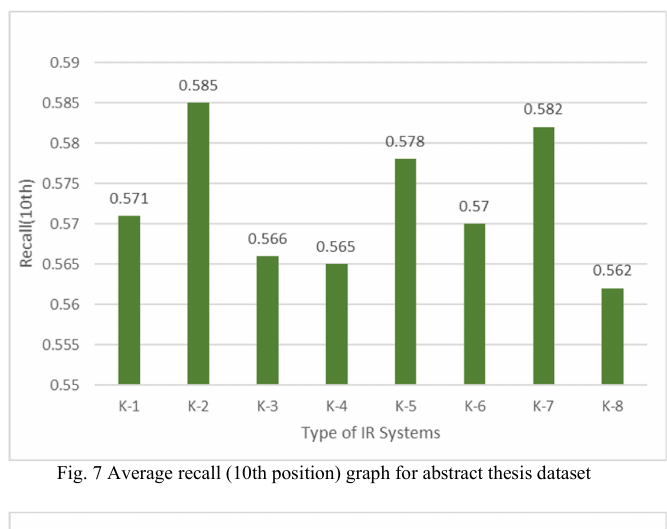
Fig. 7 Average recall (10th position) graph for abstract thesis dataset